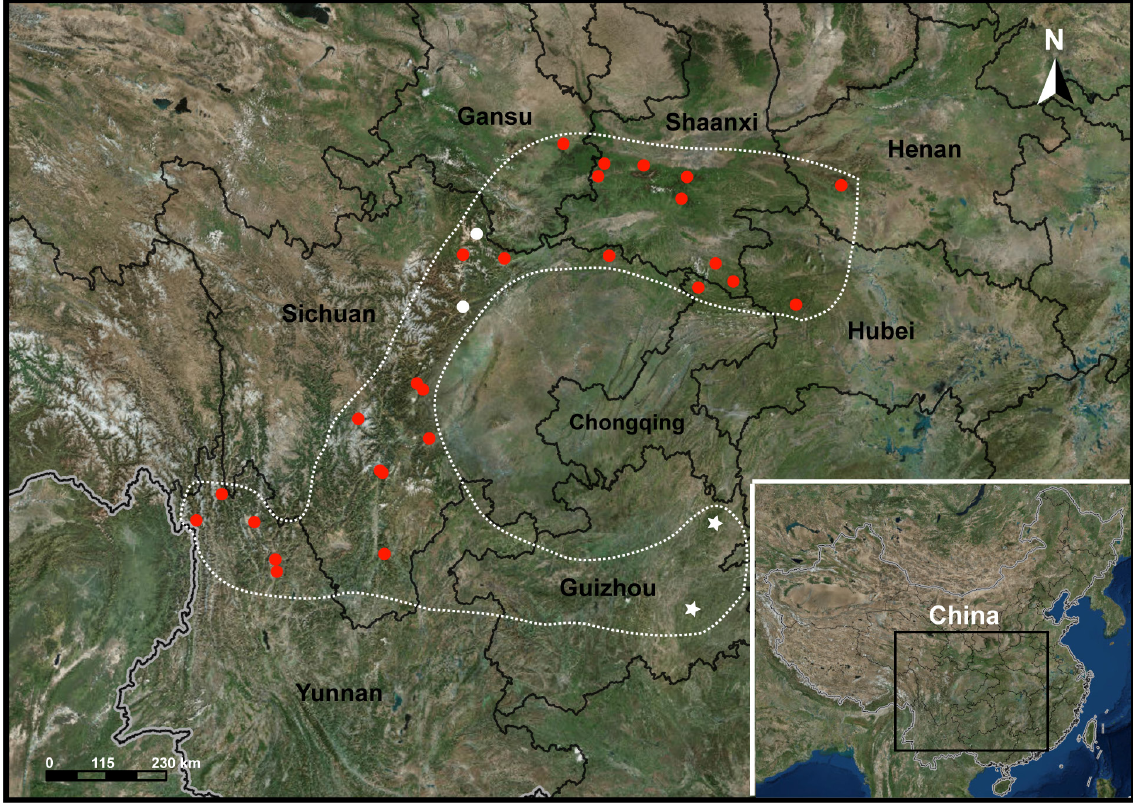
Fig. 1. Geographical distribution of Dicerapanorpa Zhong & Hua, 2013. The white dots represent the type locality of D. bifurcata sp. nov., the white asterisks indicate the type locality of D. zhengkuni sp. nov., and the red dots represent the distribution of the known species of Dicerapanorpa